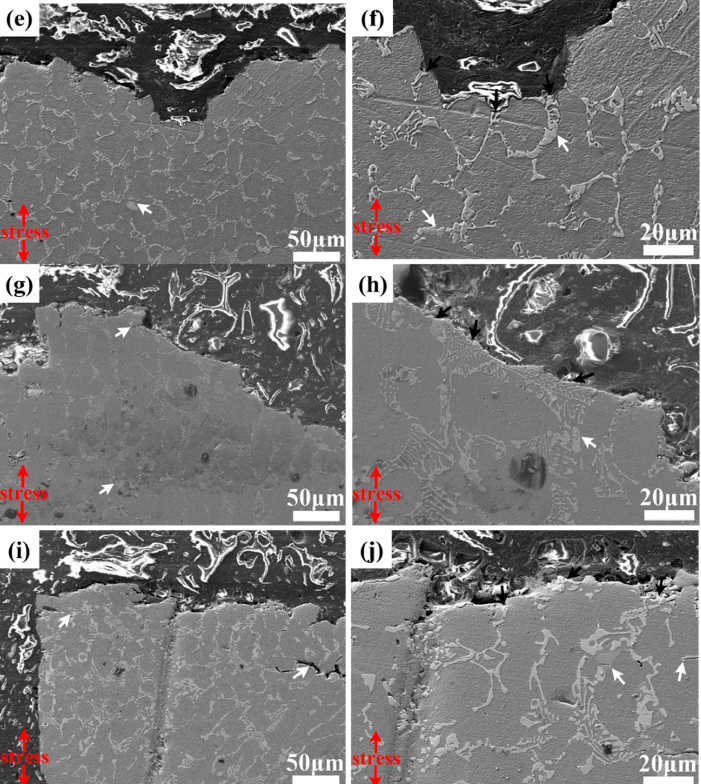
Figure 8. SEM microstructure beneath the fracture surfaces of the tensile specimens of heat-treated alloys tested at 25 °C: ( a , b ) 0 Ni alloy, ( c , d ) 0.5 Ni alloy, ( e , f ) 1.0 Ni alloy, ( g , h ) 2.0 Ni alloy, ( i , j ) 4.0 Ni alloy, ( b , d , f , h , j ) magnified pictures of ( a , c , e , g , i ), respectively. The white arrows indicate cracks in the intermetallic phases and the black arrows indicate the torn intermetallic phases.